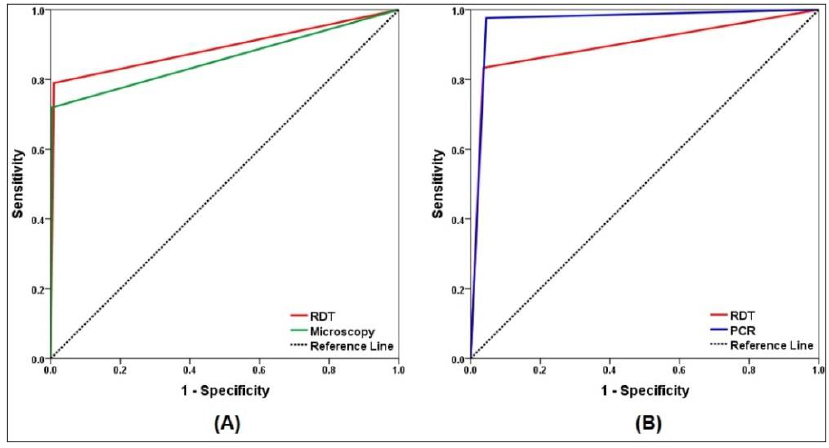
Figure 2. Receiver operating characteristic (ROC) curve analysis of malaria diagnostic techniques. ( A ) ROC for microscopy and RDT versus PCR as reference method. ( B ) ROC for PCR and RDT versus microscopy as reference method.